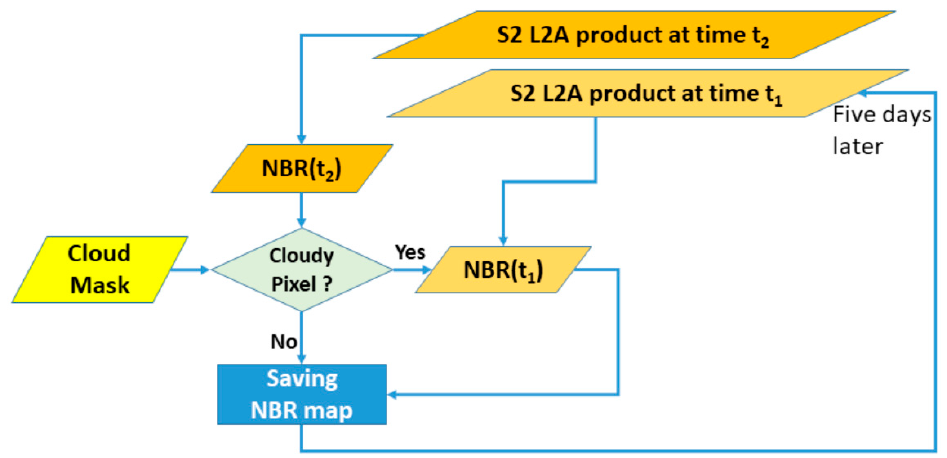
Figure 5. Saving and update of normalized burned ratio ( NBR) maps (the mechanism is identical for NDVI maps).